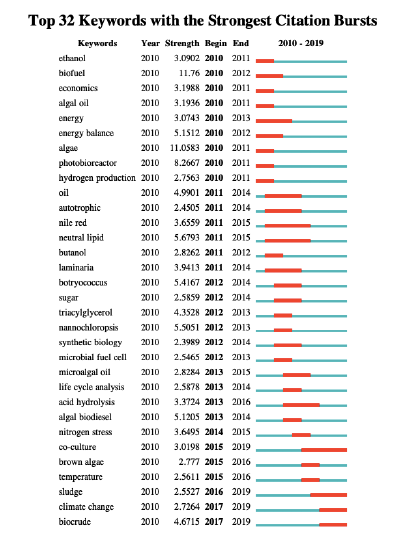
Figure 10. Top 32 keywords with the strongest citation bursts during 2010 to